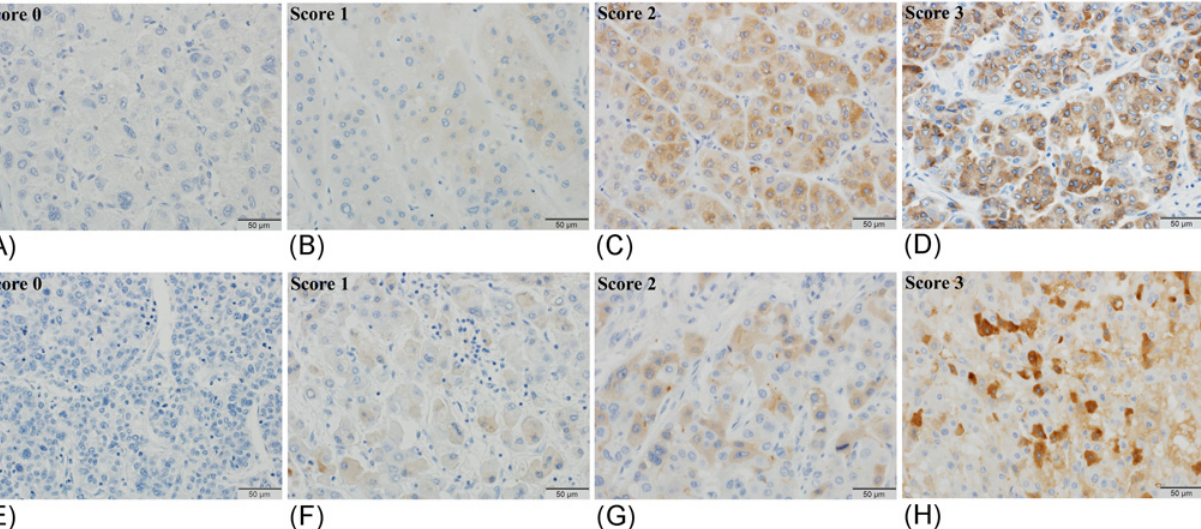
Fig 2. Immunostaining of DCP (A-D) and NX-DCP (E-H) in HCC tissues. The staining intensity was graded into 4 levels, i.e., 0, negative; 1, weakly positive; 2, moderately positive; 3, strongly positive.